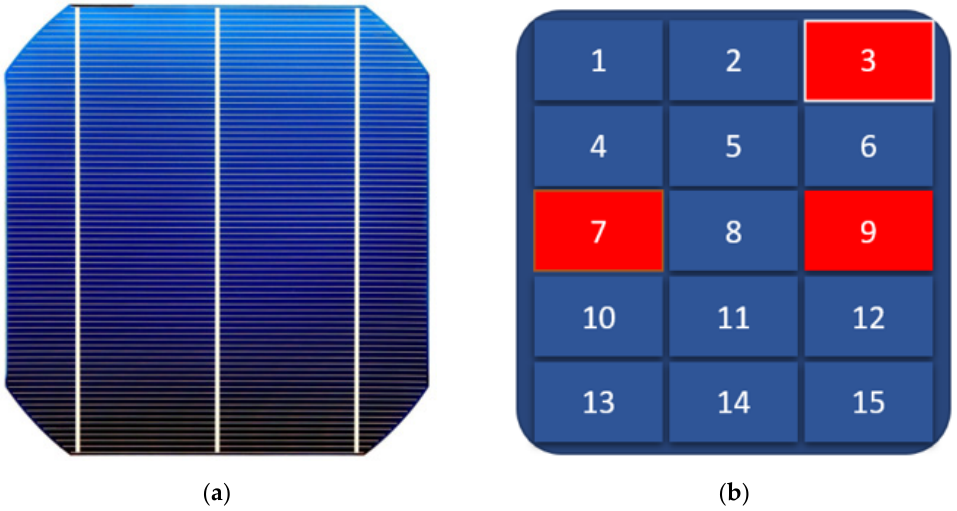
Figure 5. ( a ) Commercial Single c-Si Solar Cell, ( b ) Single Solar Cell with Assumed Defect